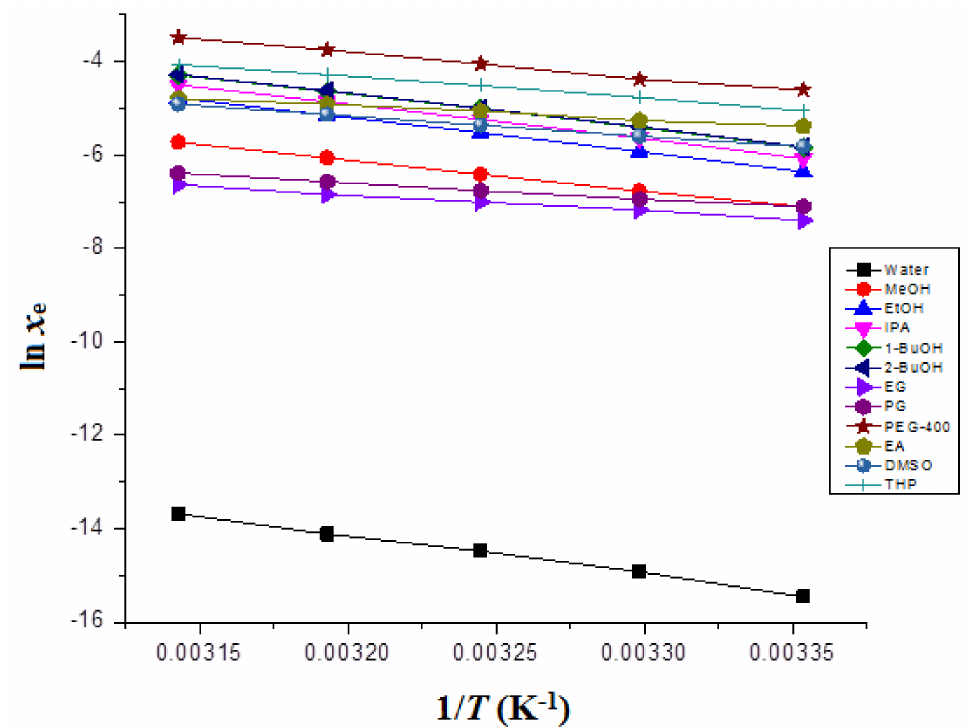
Figure 6. Correlation of experimental FBX solubilities with the “Apelblat model” in several mono solvents as a function of 1/ T ; symbols denote the experimental FBX solubility data, whereas solid lines denote the “Apelblat model” FBX solubility data.